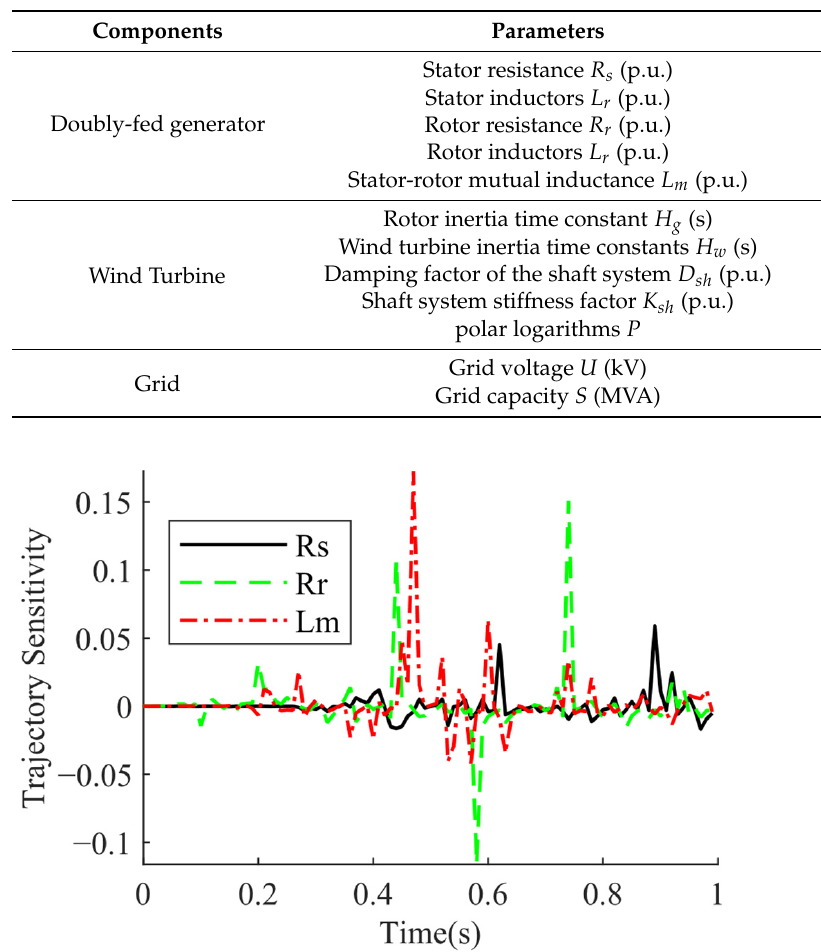
Table 3. Parameters of the model.